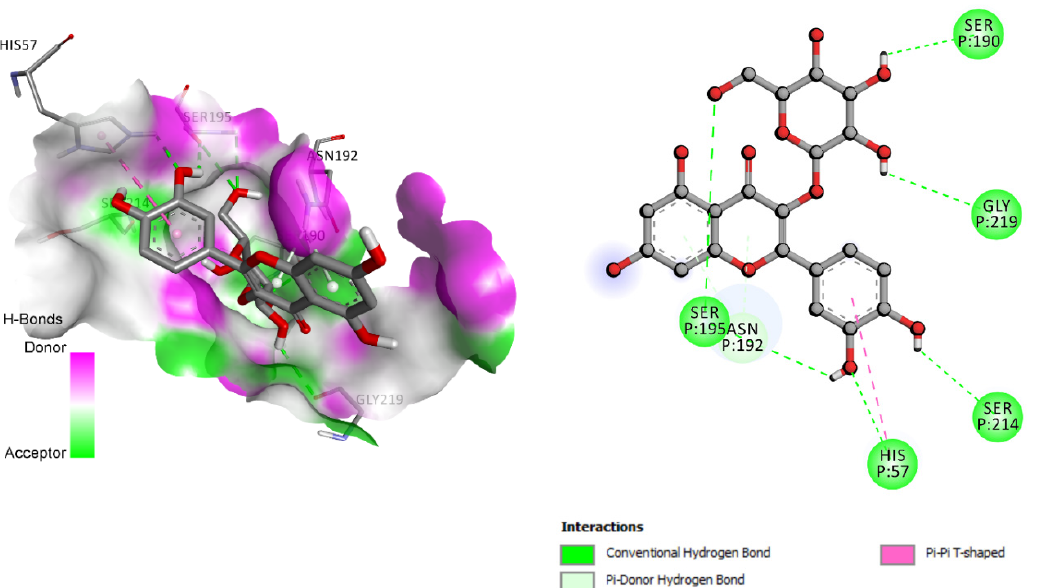
Figure 6. 3D and 2D protein–ligand interactions at the collagenase active site of the isoquercetin (PDB CID: 1CGL).